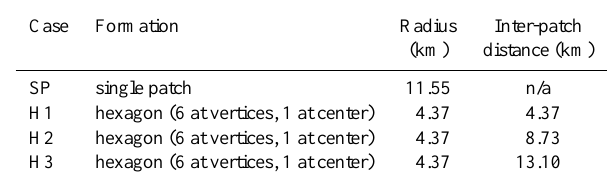
Table 2. List of cases for S3 simulations for multiple patches. Each case branches off from N130 of S1 at 3h, performed with the large domain (102.4km domain width), and is run for 9h. The total area fraction covered by the patches is 0.04 and n t = 30mg − 1 . The inter- patch distance is the shortest distance between the sides of two